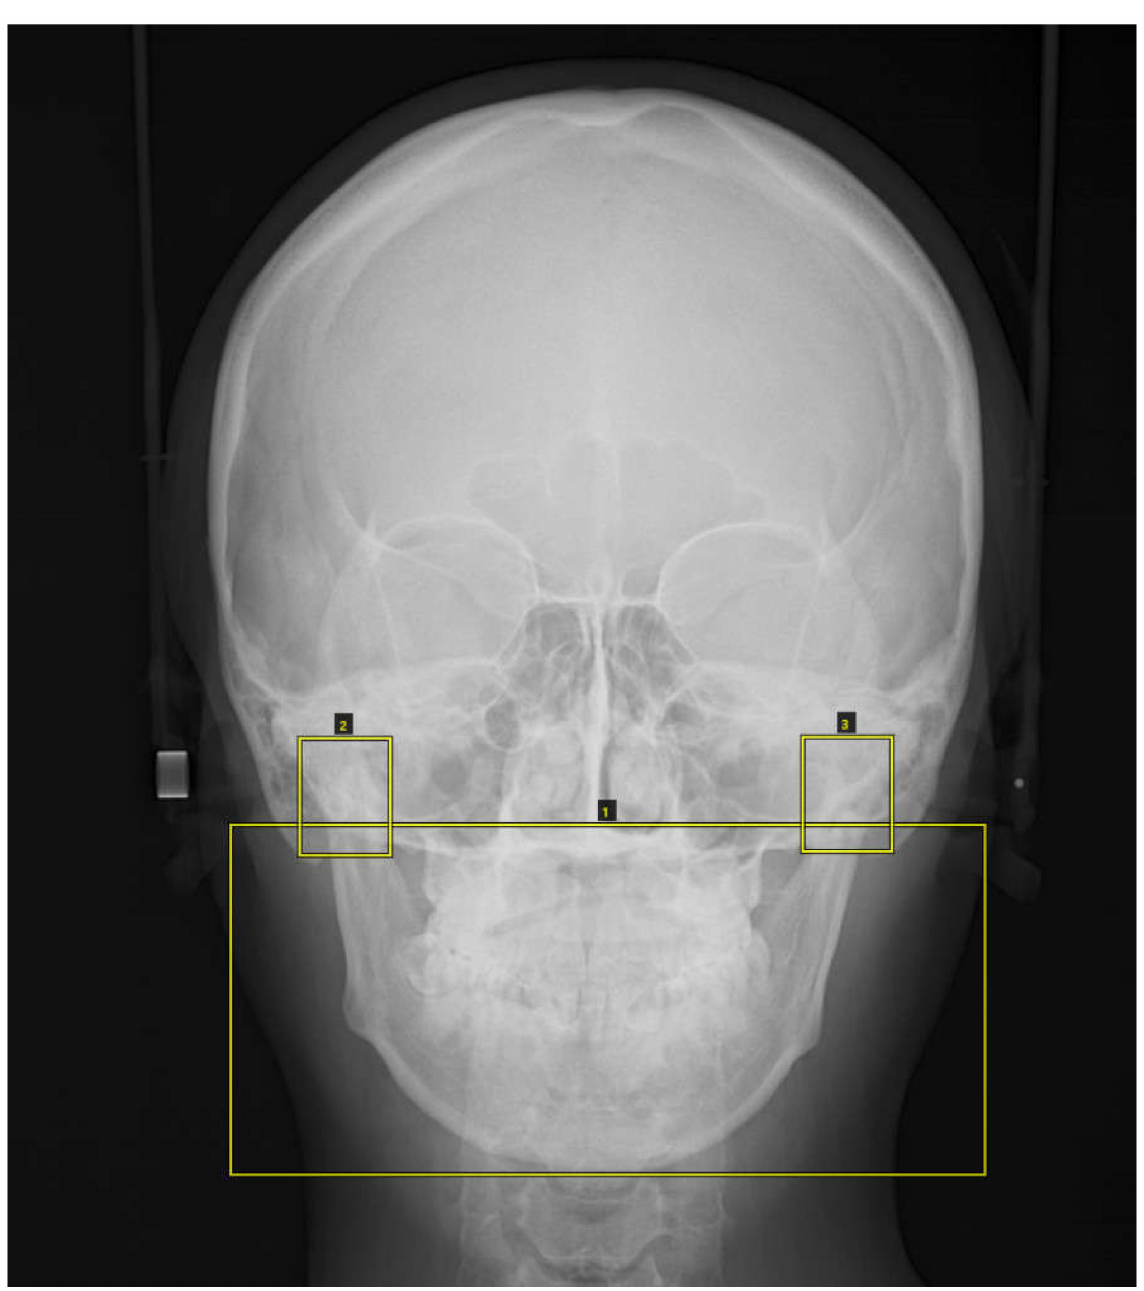
Figure 1. The posterior–anterior (PA) cephalometric images were masked with three square markers: a lower large square containing maxilla and mandible (nasal floor and hard palate region ~ inferior border of mandible) plus right and left small squares containing the condylar